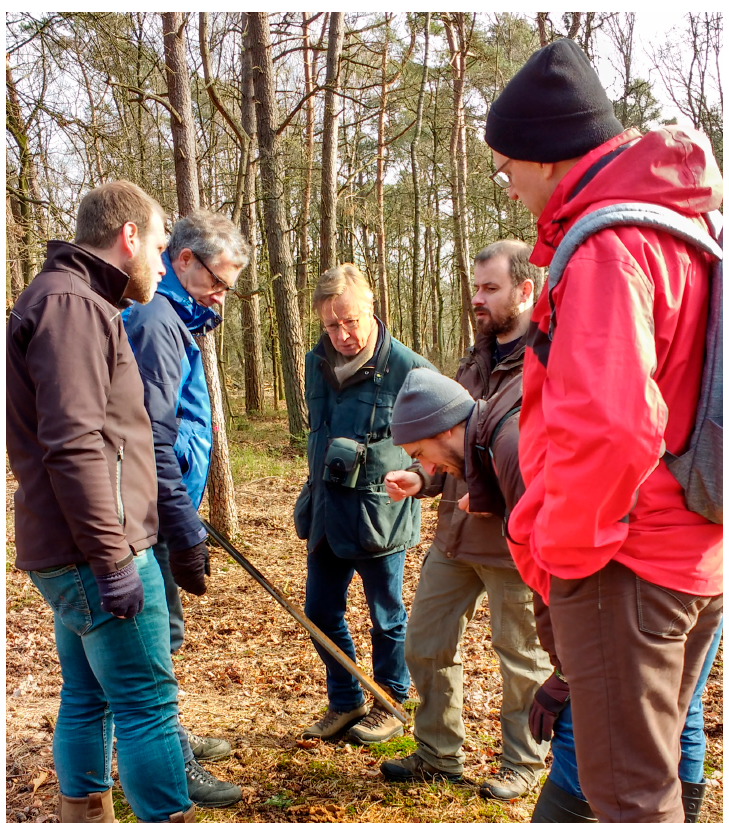
Figure 8. The validation of a new potential barrow through hand corings in early 2019, from left to right: R. Kramer ( Erfgoed Gelderland ), M. Wispelwey ( Samenwerkingsverband Noord Veluwe ), G. Scheltema ( Archeologische Werkgroep Nederland ), Q.P.J. Bourgeois (Leiden University), W.B. Verschoof-van der Vaart (Leiden University), and K. Lambers (Leiden University) (Photograph by E. Kaptijn ( Erfgoed Gelderland )).